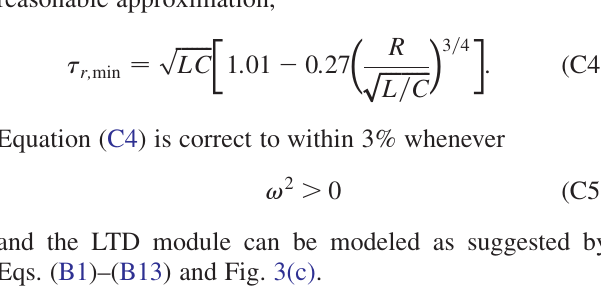
FIG. 10. (Color) The ratio (cid:1) r; min = The quantity (cid:1) r; min is the minimum current-pulse rise time that can be achieved by an impedance-matched LTD module when Eqs. (1), (2), and (10) are satisfied. L and C are the inductance and capacitance, respectively, of a single LTD cavity. R , which is defined by Eq. (C2), is the total effective series resistance of the RLC circuit that represents a single